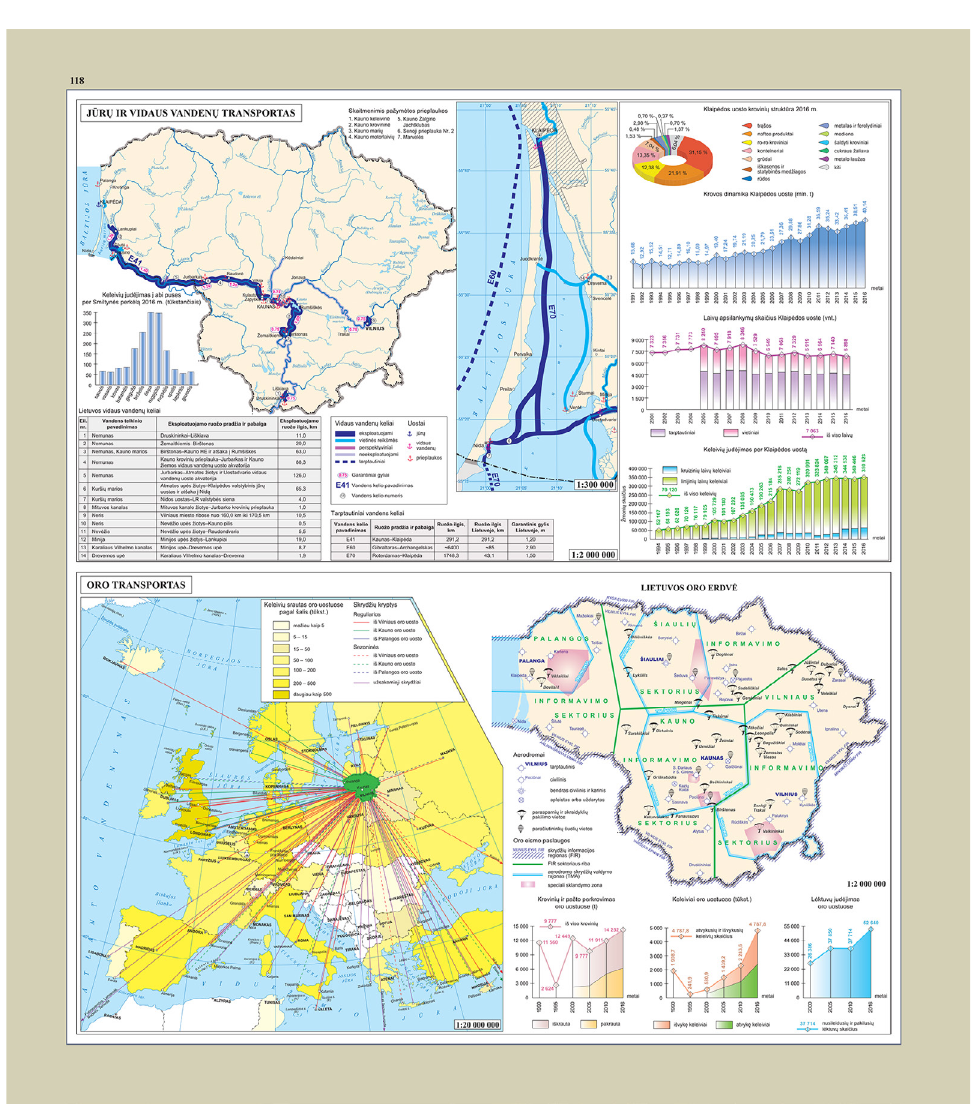
Fig 4. Maritime and inland waterway transport (above); air transport (below): international connections, airports and airfields (reduced – original scales 1:2,000,000, 1:300,000 and